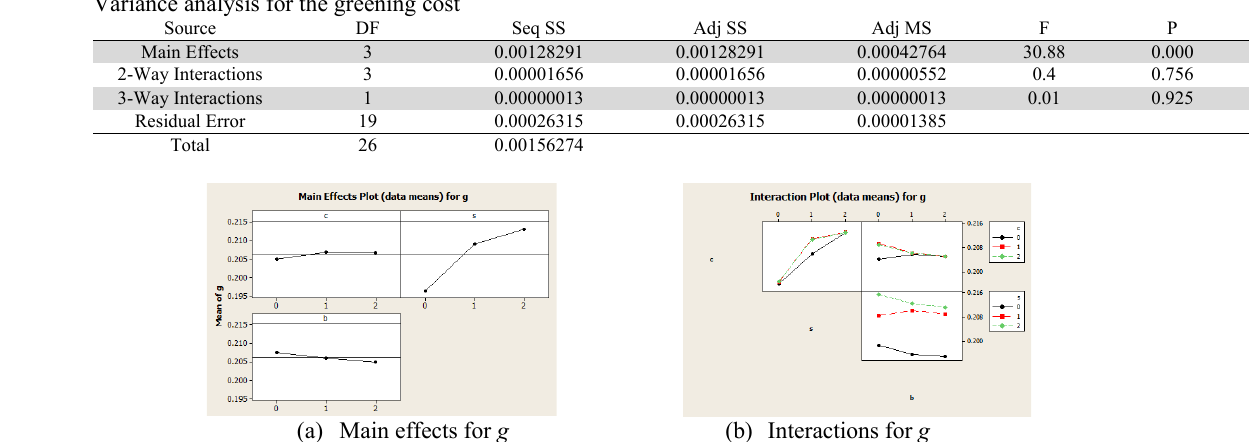
Variance analysis for the greening cost Source